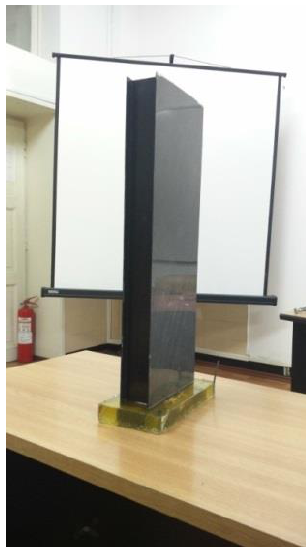
Fig. 5 The composite wing